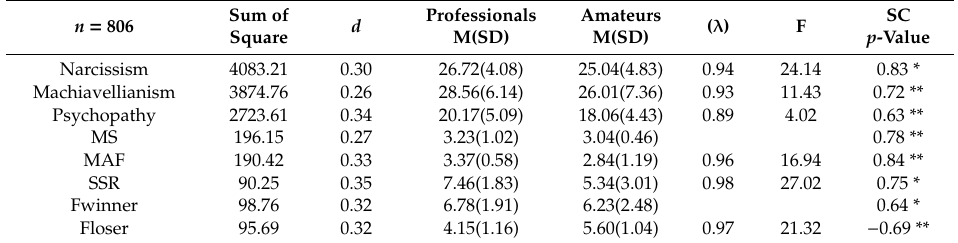
Table 2. Discriminant analysis between groups (professional vs. amateurs) in dark personality competitiveness and sporting feelings